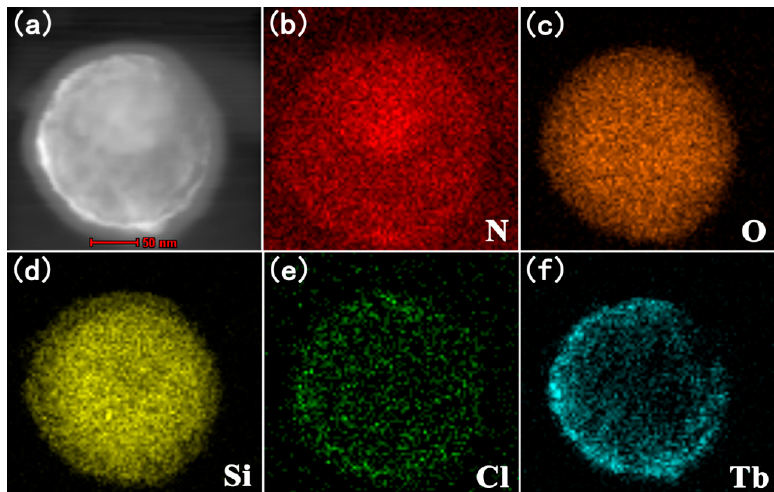
Figure 4. Bright-field scanning transmission electron microscopy (STEM) image of a single SiO 2 @PMDA-Si-Tb@SiO 2 ( a ) and the associated energy dispersive X-ray spectroscopy (EDX) elemental mappings showing the distribution ( b – f ).